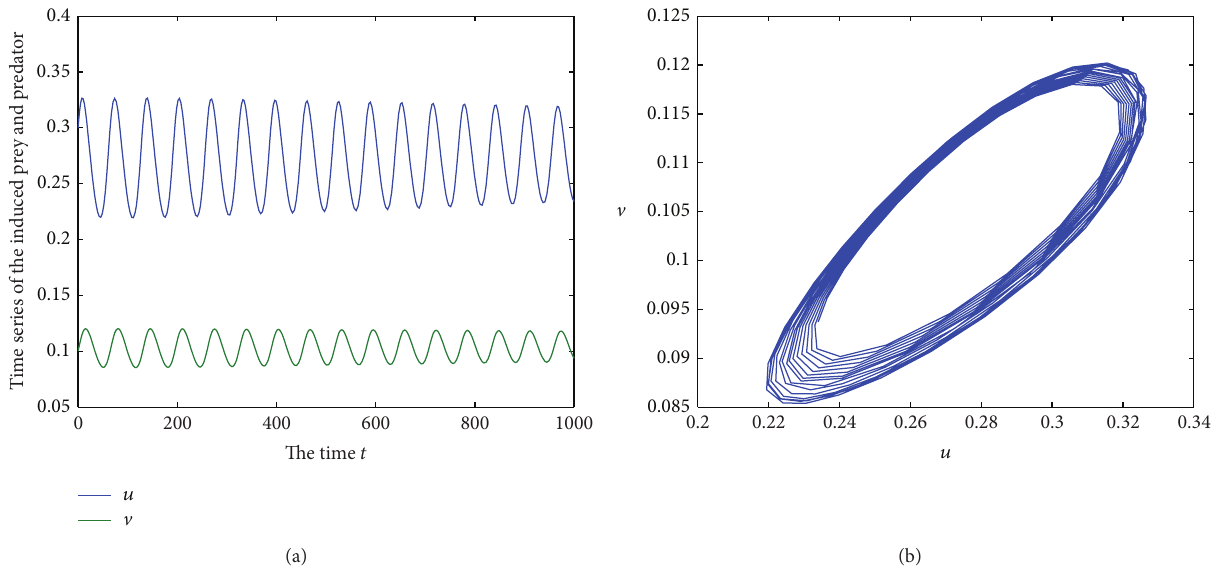
Figure 2: Behavior and phase portrait of system (6). Parameter values are used as 𝛼 = 0 . 6, 𝛽 = 0 . 8, 𝛾 = − 0 . 3, 𝛿 = 0 . 58, 𝜃 = 2 . 2, and 𝜏 = 0 . 81 > 𝜏 𝑐